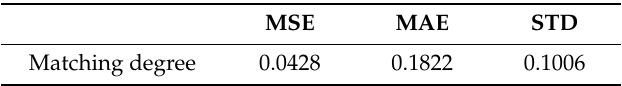
Table 3. Significant comparison of characteristic quantities.